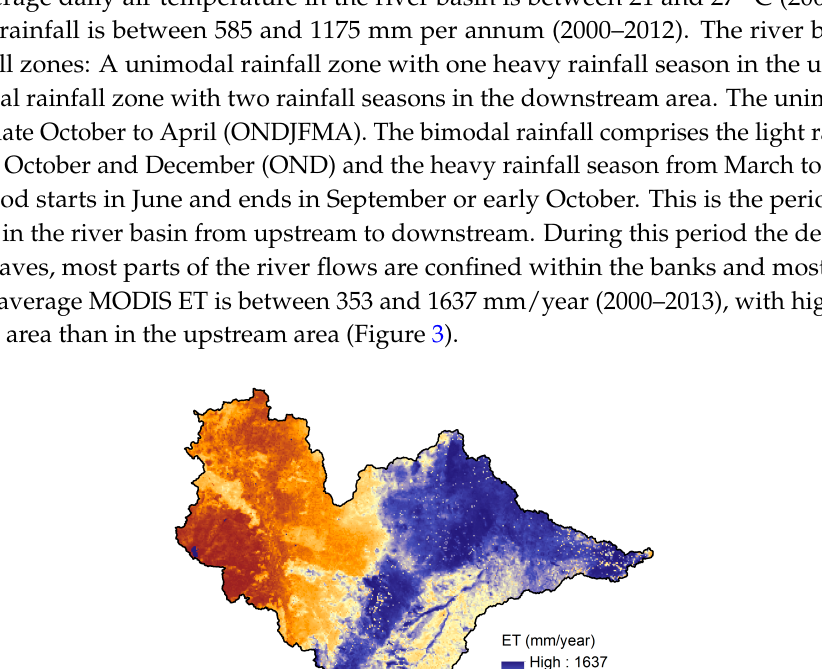
Figure 2. Topograhic slopes (derived from STRM-90m), soil texture classes of the year 2003 [36] and land use classes of the year 1997 [37].